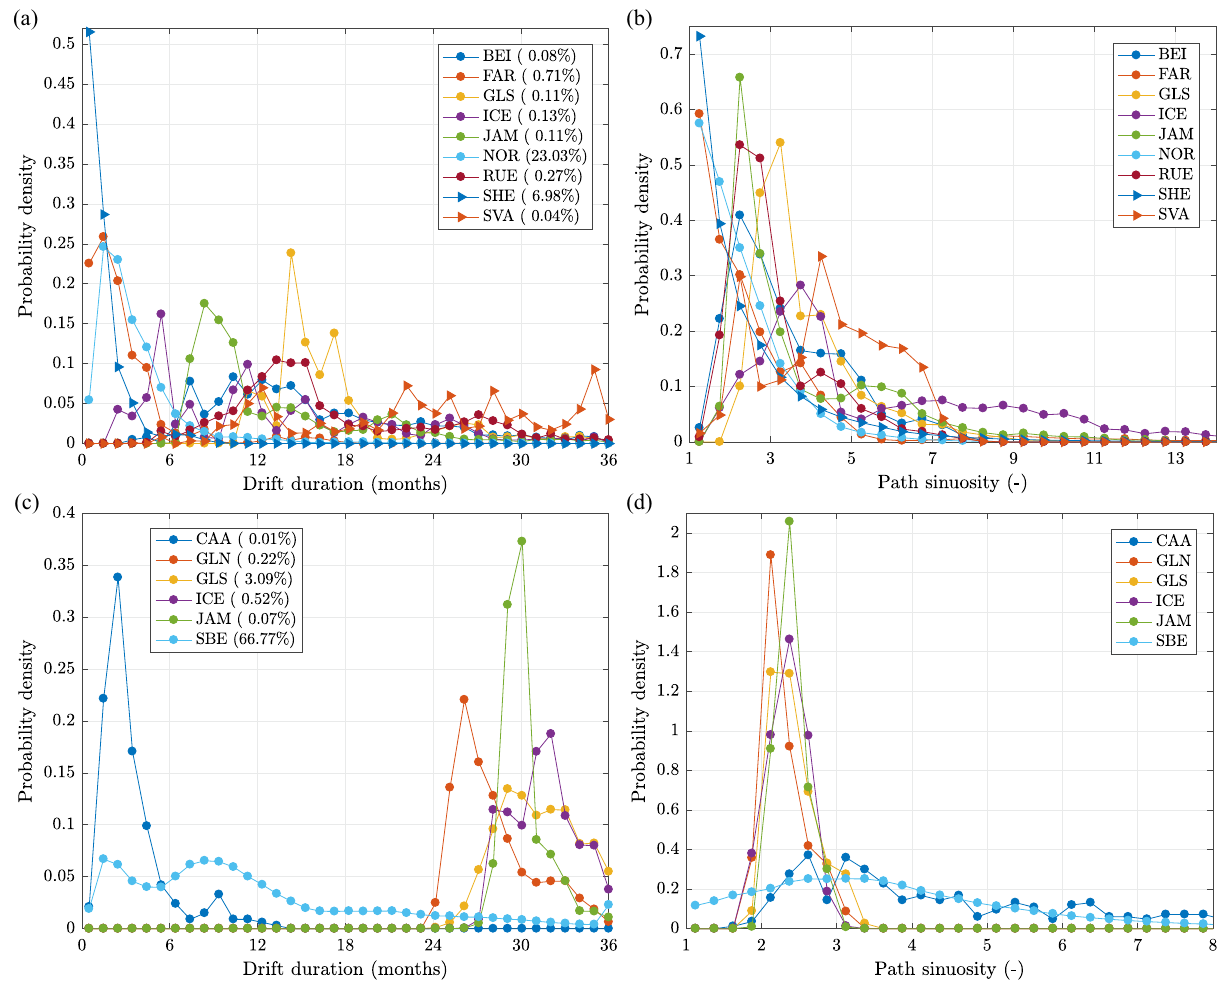
Figure 4. Probability distributions of drift duration ( a , c ) and path sinuosity ( b , d ) for trajectories originating at GBR ( a , b ) and ALA ( c , d ). The bin widths equal 1 month in ( a , c ), 0.5 in ( b ) and 0.25 in ( d ). Only those destination regions are shown, which are reached by at least 0.01% of all paths originating at a given source region (nine for GBR and six for ALA; values in the legend entries in panels a , c